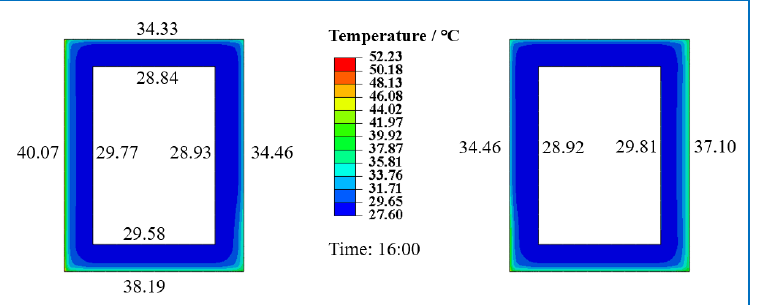
Figure 26. Two-dimensional temperature field cloud of tower column section at a 125 m height.